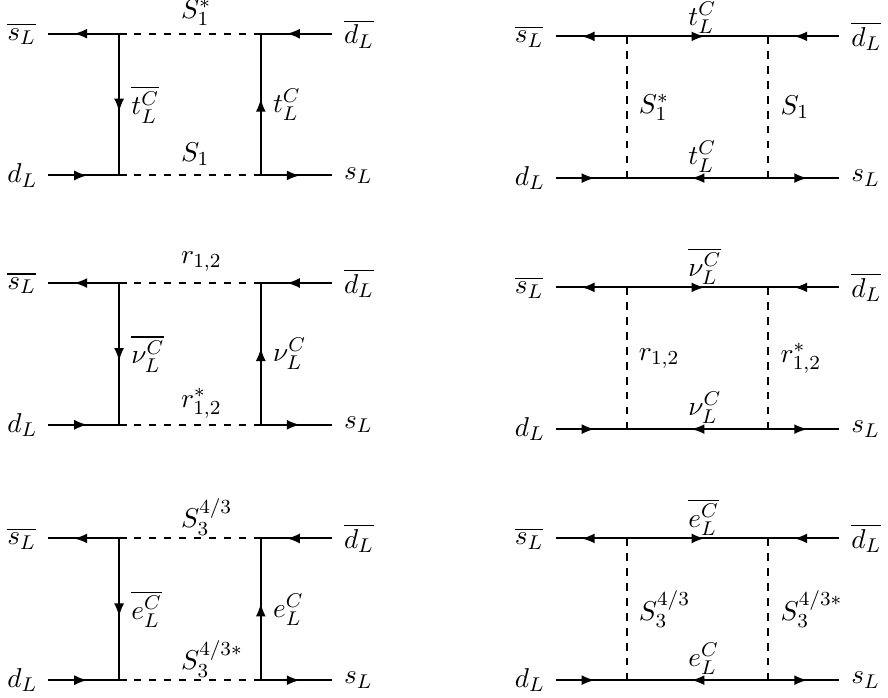
Figure 11 . Dominant contributions to K (cid:0) K